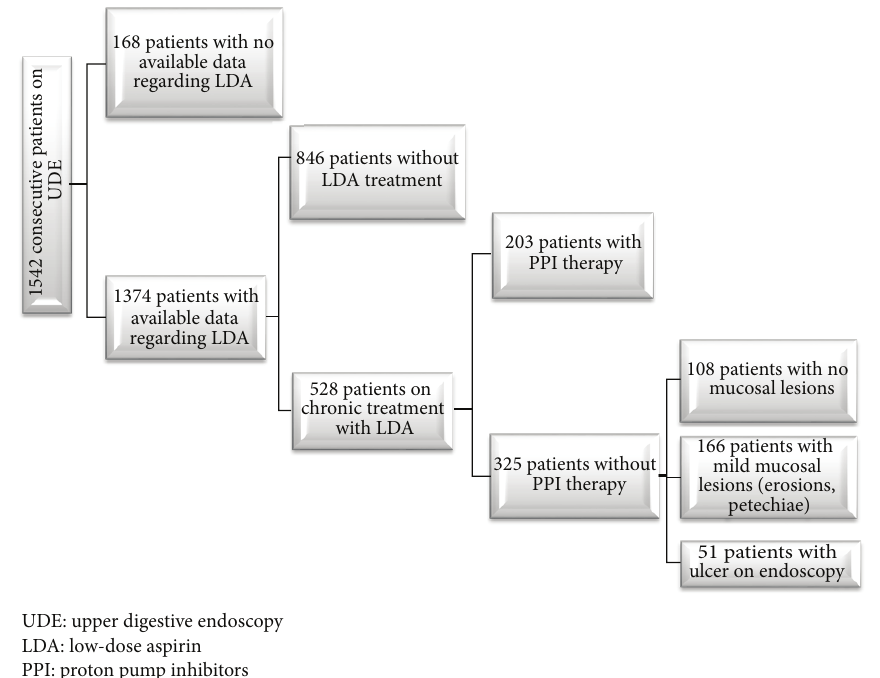
Figure 1: Flowchart regarding patients’